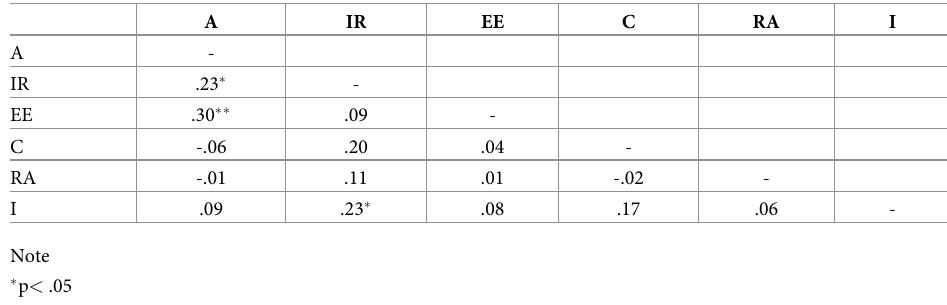
Table 4. Correlations between age (A), inferential response (IR), epistemic status (EE), comprehension (C), read- ing ability (RA) and intelligence (I) in Study 2.